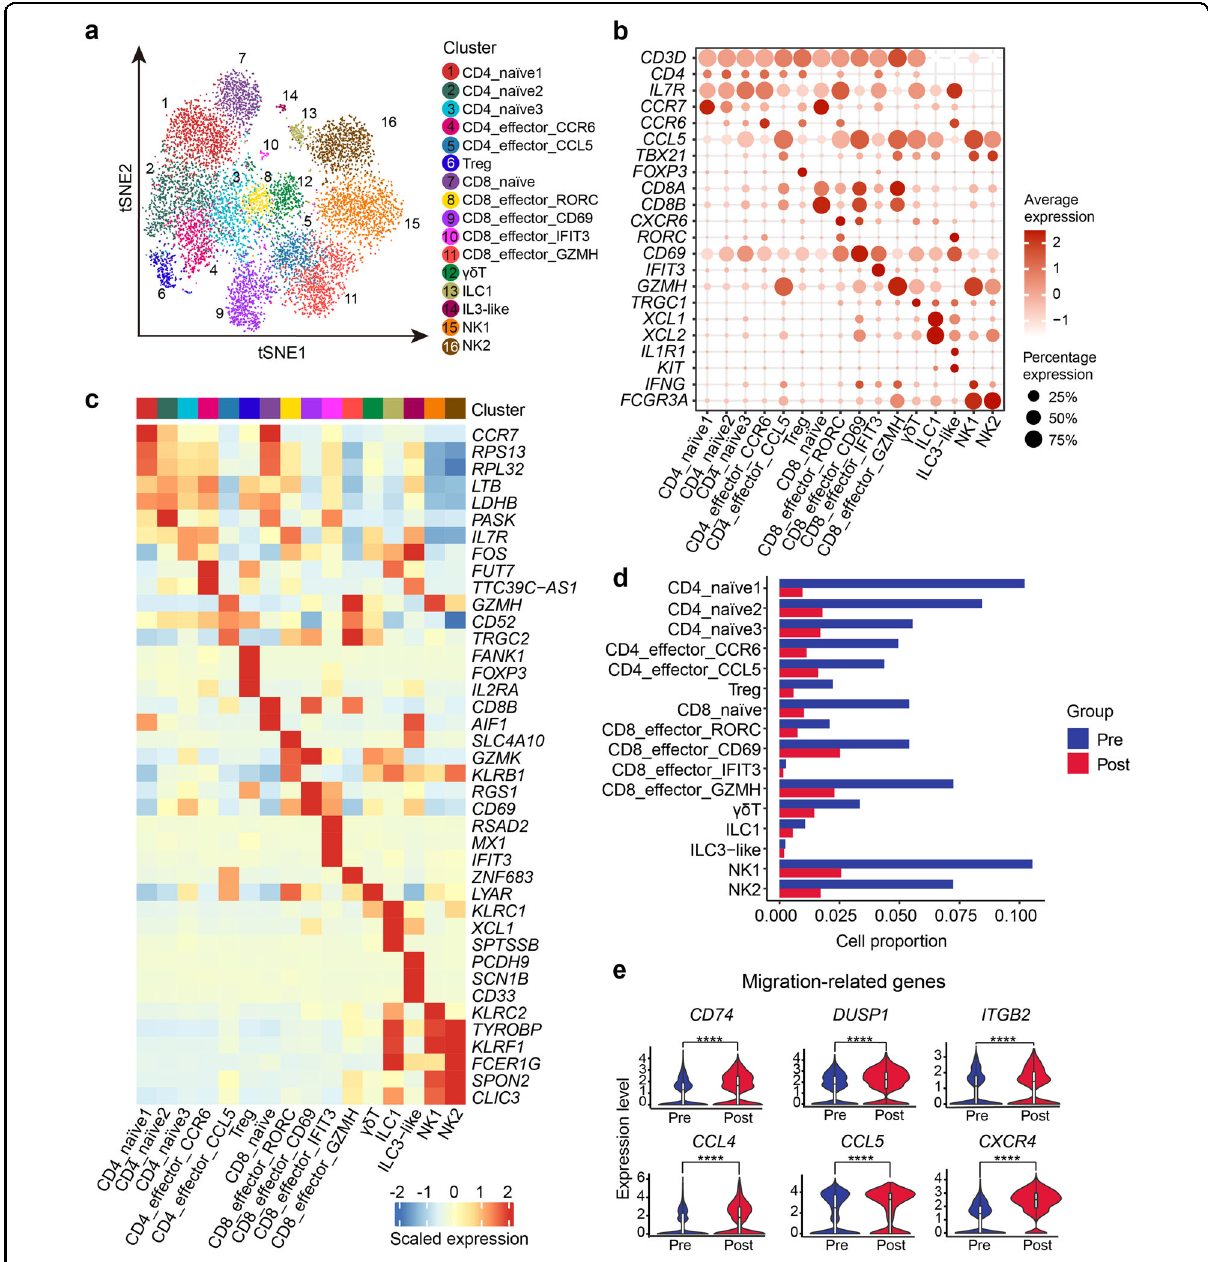
Fig. 3 Sub-clustering of T/NK lineage in human BM before and after G-CSF mobilization. a t-distributed Stochastic Neighbor Embedding (t-SNE) visualization of 16 subclusters of the T/NK lineage pooled from human BM across two donors. Treg, regulatory T cell; γδ T, gamma-delta T cells. b Identi fi cation of subclusters of T/NK lineage based on the expression of key cell type-associated marker genes. c Heatmap showing scaled expression of top 3 DEGs of the subclusters in T/NK cells. Detailed DEGs can be found in Supplementary Table S4. d Bar plot displaying the changes in the percentage of various subclusters of T/NK cells upon G-CSF administration. e Violin plots showing the changes in expression of genes related to leukocyte migration upon G-CSF administration. Representative upregulated DEGs enriched in leukocyte migration (GO: 0050900) are displayed. **** P value <